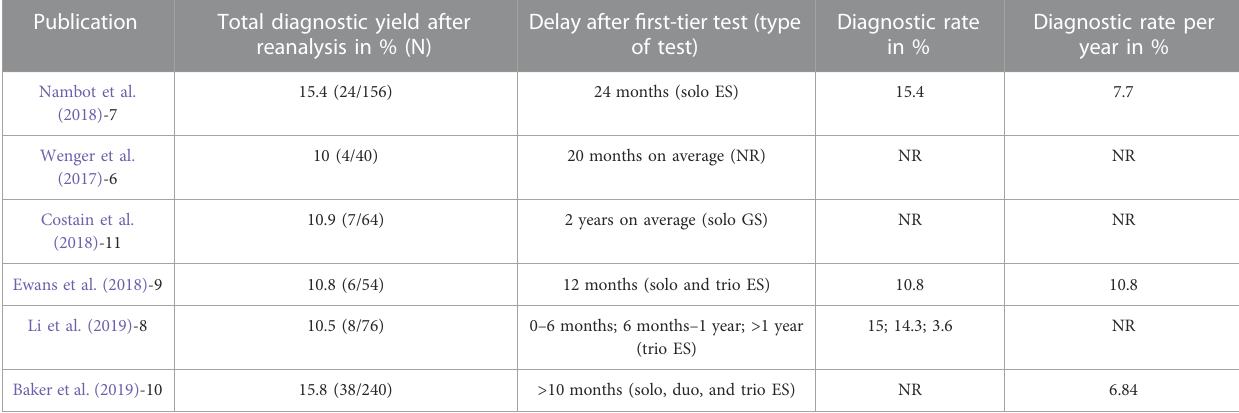
TABLE 1 Manuscripts focusing on a reanalysis strategy with diagnostic yield and delay. ES: exome sequencing; GS: genome sequencing; NR: not